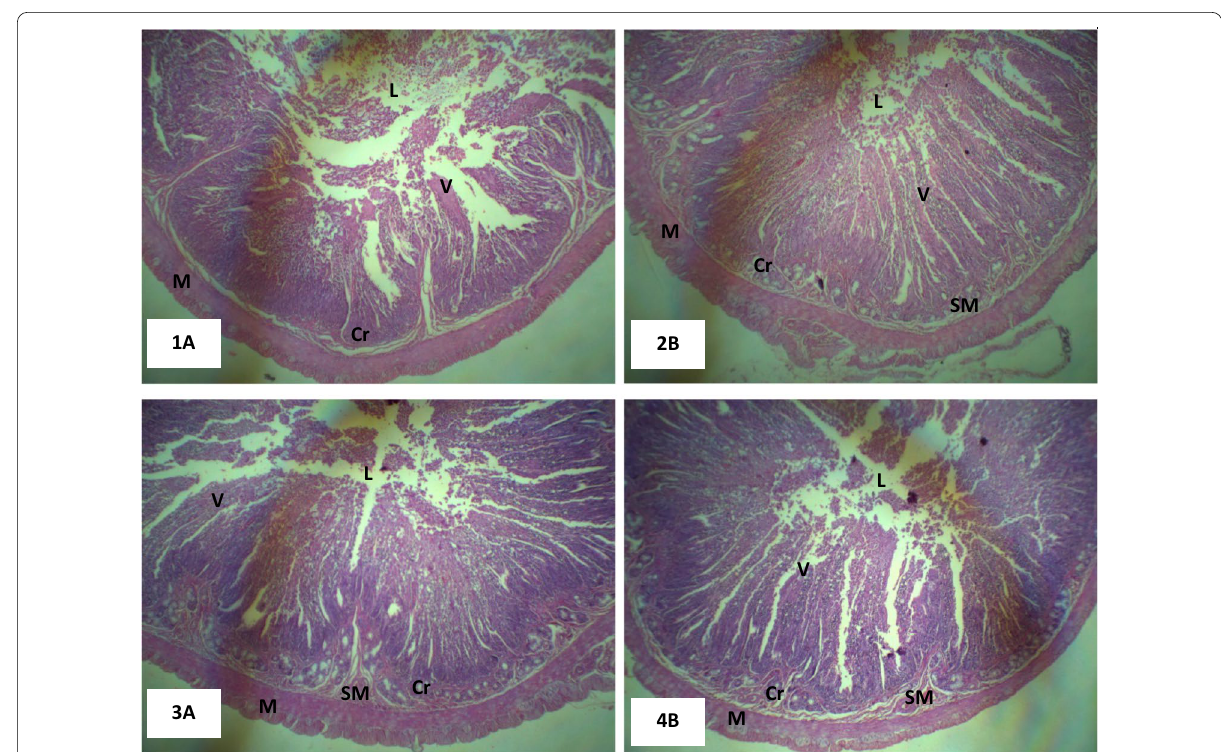
Fig. 1 Cross section through small intestine (ilium) from rabbits of different dietary treatments at 18 weeks of age. (M) muscularis mucosa; (SM) submucosa; (Cr) crypts of Lieberkühn; (V) Villi; (L) lumen. ((H & E cerevisiae 0.05% B. +